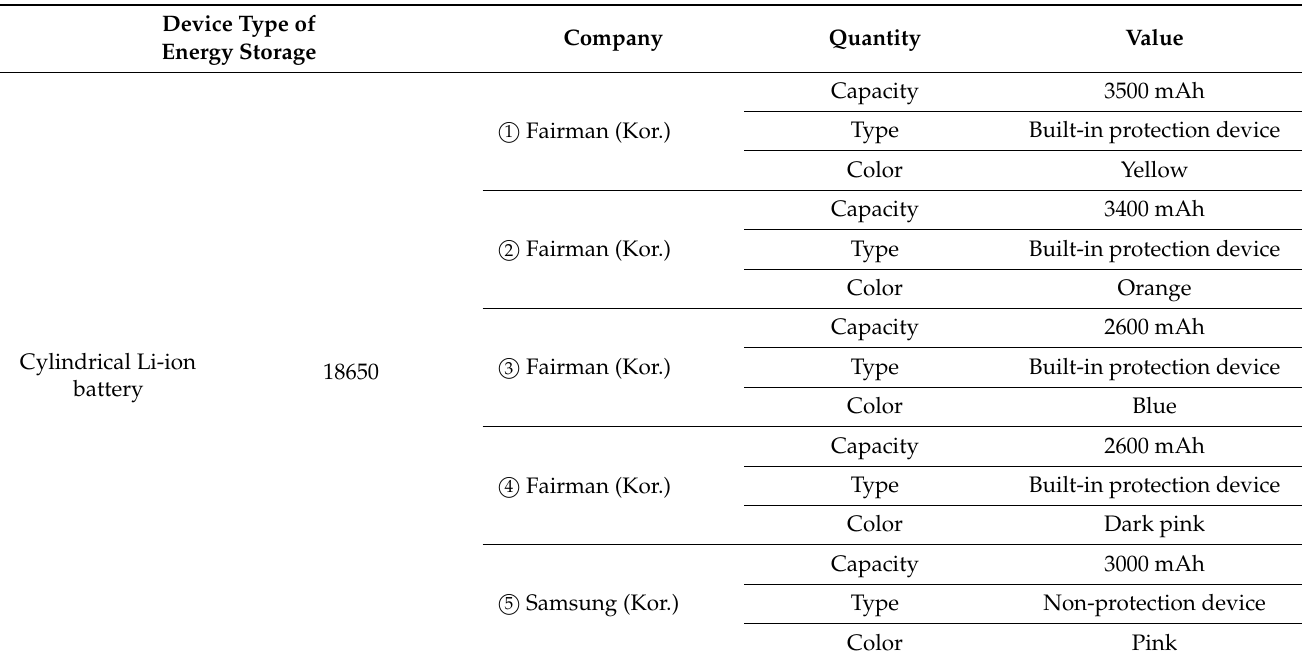
Table 1. Specifications and parameters of the Li-ion batteries and